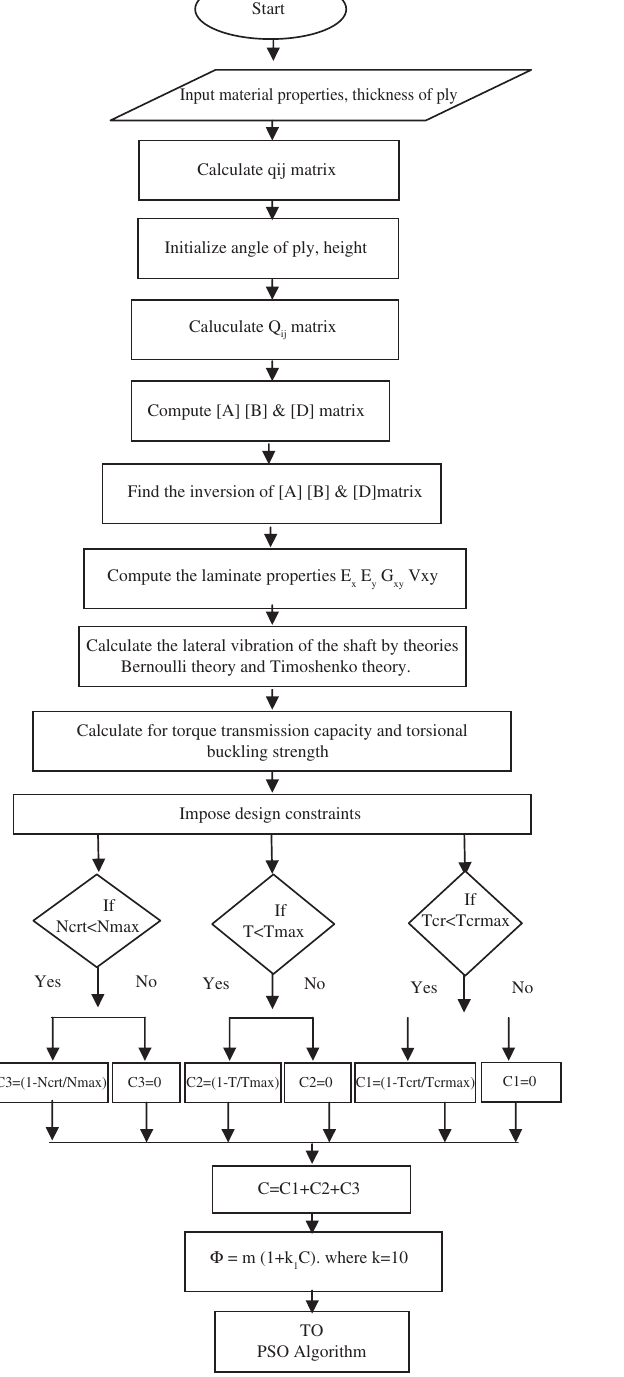
Figure 3. Design algorithm of composite drive shaft.